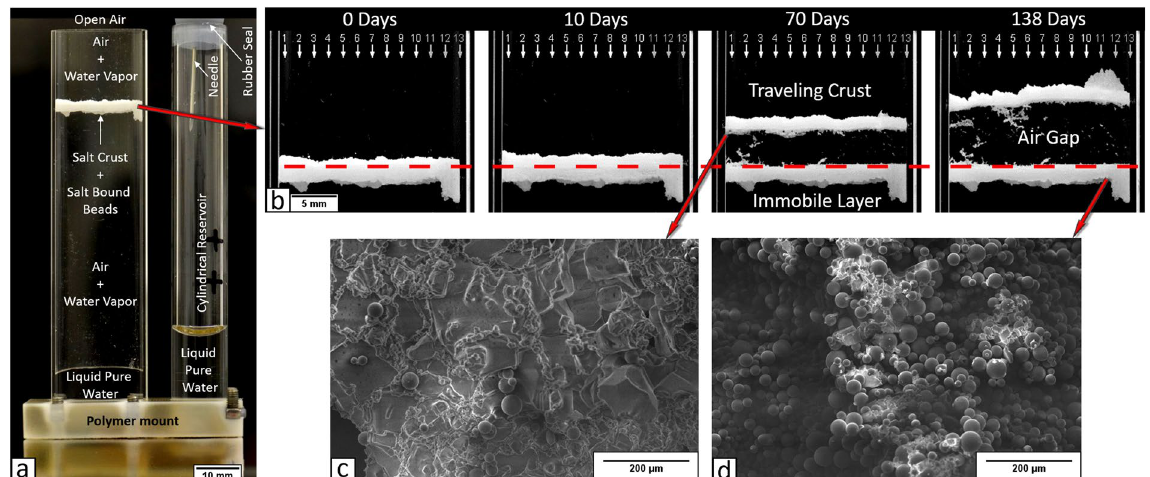
Figure 1. ( a ) Experimental setup at the beginning of the experiment, with the Hele–Shaw cell connected to the adjacent cylinder. ( b ) Upward displacement of the porous crust and detachment from the glass bead layer leading to the air gap formation. The red dashed line corresponds to the uppermost position of the glass bead packing partially filling the cell during the drying step in which the crust forms. ( c , d ) Scanning Electron Microscopy (SEM) observations of crust after the end of the experiment ( c ) detached porous salt crust and ( d ) lower immobile layer after crust detachment